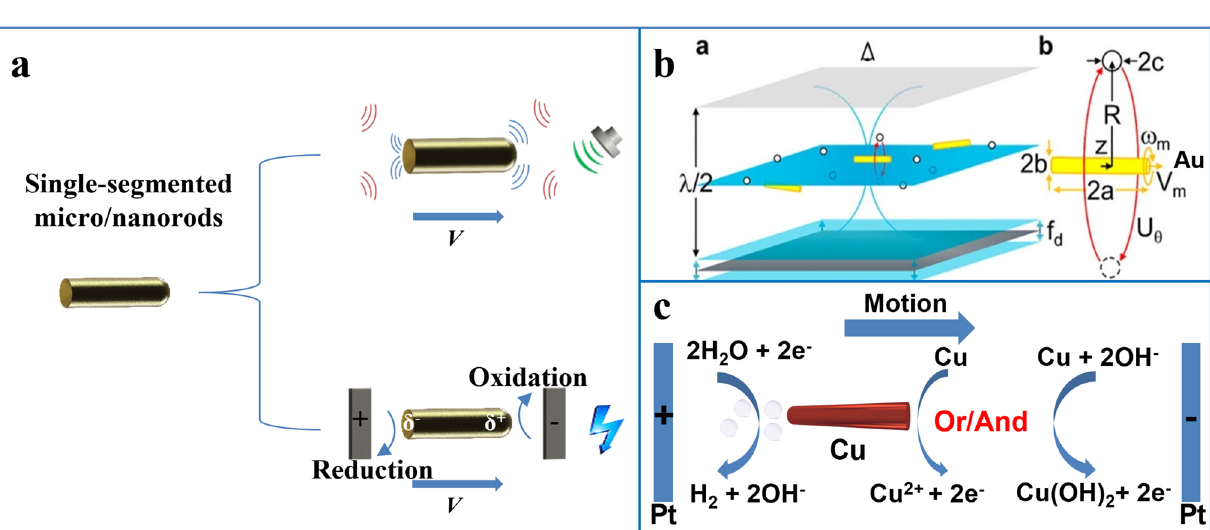
Fig. 3 a Single-segmented nanorods driven in ultrasonic fields and electric fields. b Driving mechanism of the gold nanorod motors in the acoustic field. Reprinted with permission from Ref. [20]. Copyright (2014) American Chemical Society c Driving mechanism of the Cu nanorod motors in the electric